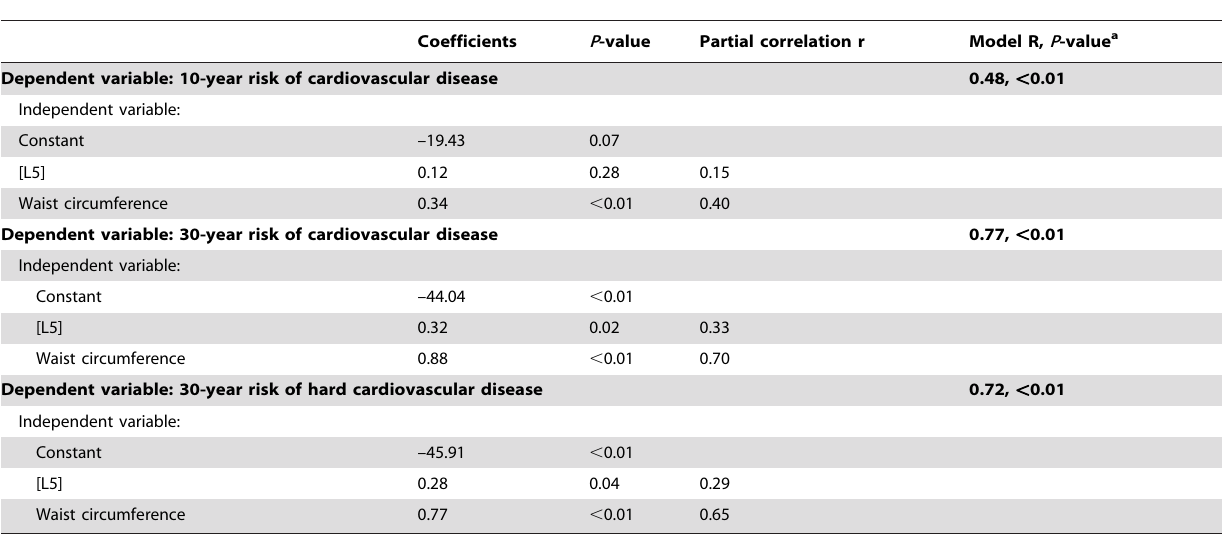
Table 5. Multivariate analysis of CVD risks in terms of L5 concentration [L5] and waist circumference